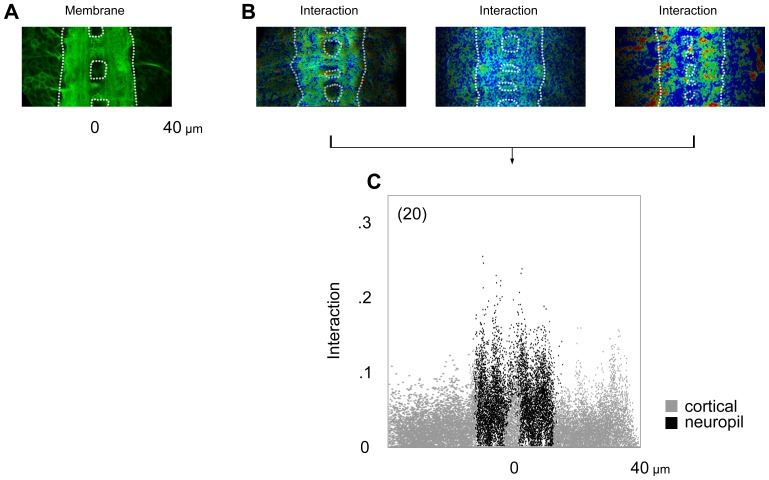
Pixel-resolution analysis.A. Neuropil emerges near the center of the CNS as a plasma membrane-enriched region by hour 21 (dotted line). B. Samples from a given experiment show both variability and consistency. C. Pixoplot displays individual pixels from multiple samples (n) along the axes of interaction and spatial position within the bilateral CNS. Black color indicates pixels with neuropil assignment.